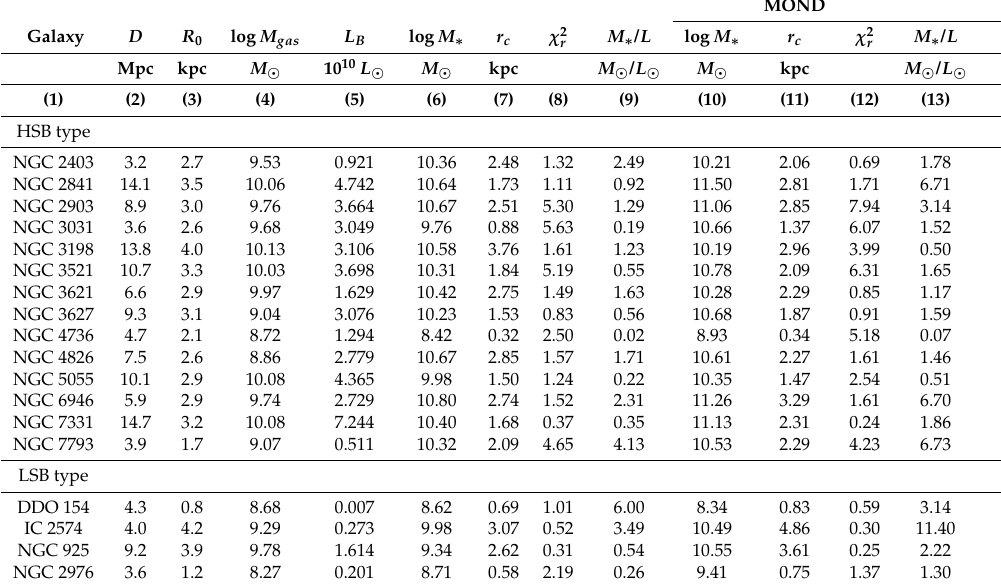
Table 1. Best fit results according to Equation (19) using the parametric mass distribution Equation (7). These numerical values correspond to rotation curves presented in Figure 1. Column (1) name of galaxy; Column (2) distance; Column (3) measured scale length of the galaxy; Column (4) base ten logarithm of total gas mass given by M gas = 4/3 M HI , with the M HI data taken from [55]; Column (5) galaxy luminosity in the B-band calculated from [55]; Column (6) base ten logarithm of the predicted stellar mass M ∗ of the galaxy (obtained by subtracting M gas from the best-fit results for the total mass M 0 ); Column (7) the predicted core radius r c ; Column (8) reduced χ 2 r ; Column (9) the stellar mass-to-light ratio calculated by subtracting the mass of the gas from the total mass and then dividing it by the B-band luminosity; Column (10) base ten logarithm of MOND predicted mass of the galaxy; Column (11) the MOND predicted core radius r c ; Column (12) MOND reduced χ 2 r ; and Column (13) the MOND stelar mass-to-light ratio.